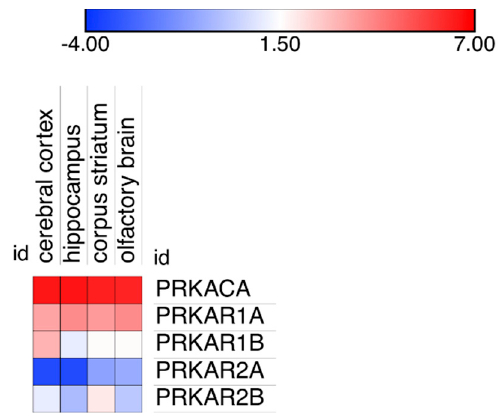
Figure 5. Expression level of the PKA catalytic and regulatory gene products in four different areas of the brain: cerebral cortex, hippocampus, corpus striatum and the olfactory brain. Data are plotted as Log(2) of the median of all expression data, reported in the original database as Transcripts per Million (TPM).